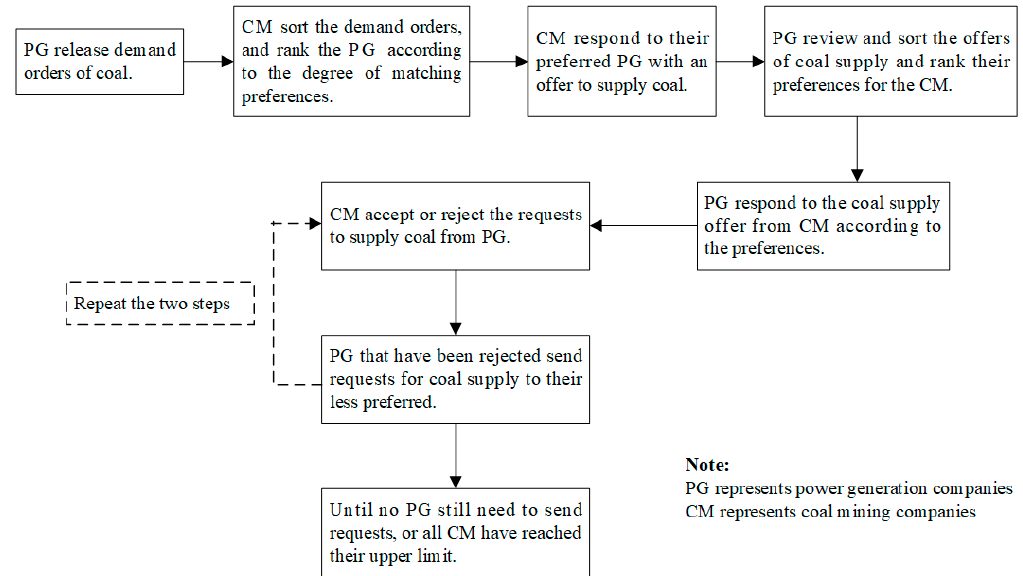
Figure 1. The stable trading matching mechanism.